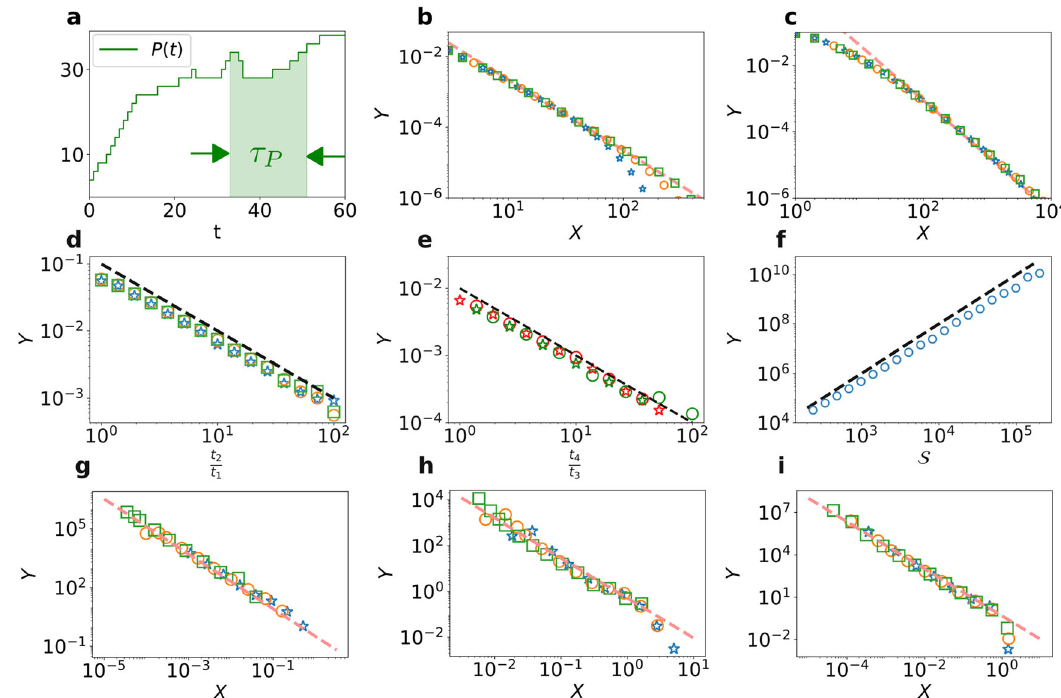
(cid:11) (cid:12) (cid:11) t t t Y = t 3 ð N ð t Þ(cid:2) N ð t Þ Þð N ð t Þ(cid:2) N ð t Þ (cid:12) t 1 1 =10, 1 =100, and 1 =1000. e 1 1 2 2 Þ , for Lévy fl ights of para- . Data in red and meter α =1.3. We compare Y to the dashed line proportional to t 3 t 4 green indicate t 1 =10 and t 1 =100. Stars indicate t 2 =2 t 1 and circles indicate t 2 =4 t 1 . We take t 3 =4 t 2 . f Lifetime at starvation. Blue circles show the mean lifetime versus the metabolic time S . The dashed line is proportional to S 2 . Non-Markovian examples . Rescaled distribution Y = F n ( τ ) n 1+1/ μ versus X = τ / n 1/ μ for g Fractional Brownian motion with parameter 1/ H =1/0.4= μ =1 − θ ( n =20, 40 and 80) h Fractional Brownian motion with parameter 1/ H =1/0.75= μ =1 − θ ( n =20, 40 and 80), i True Self Avoiding Walks μ =2/3=1 − θ ( n =200, 400 and 800). For the last three panels, increasing values of n are represented successively by blue stars, orange circles and green squares, and the dashed line is proportional to X − (2 − θ )